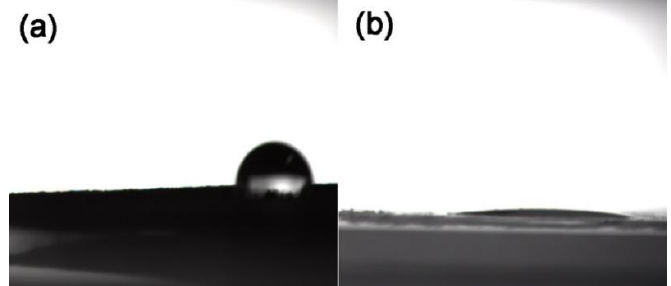
Figure 4. Water contact angle of Ru catalysts after catalytic experiments. ( a ) Ru without any additives; ( b ) Ru with ZnO and ZnSO 4 as reaction additives.